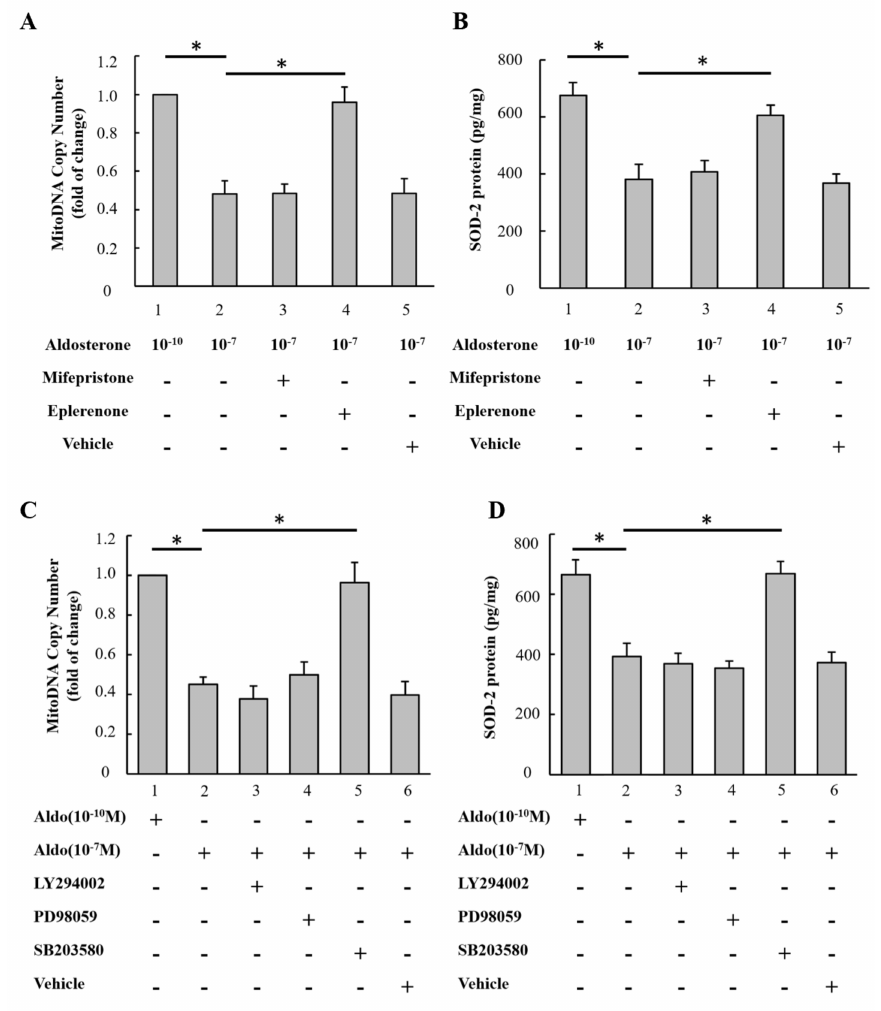
Figure 2. Aldosterone-associated reduction in mitochondrial DNA and protein via MR and MAPK/P38 pathway. ( A , B ) Role of MRs and glucocorticoid receptors on mitochondrial DNA and SOD2 protein. H9c2 cells were treated with 10 − 7 M eplerenone (an MR antagonist), 10 − 7 M mifepristone (a glucocorticoid receptor antagonist) and vehicle (equal volume of DMSO) for 1 h prior to 10 − 7 M aldosterone treatment. After 72 h, mitochondrial DNA was determined by qPCR and the expression of SOD2 was determined by ELISA. ( C , D ) Role of signaling mediators on mitochondrial DNA and SOD2. H9c2 cells were treated with 5 µ g/mL SB203580 (an MAPK/p38 inhibitor), 50 µ g/mL PD98059 (an MEK/ERK inhibitor), 50 µ g/mL LY294002 (a PI3K/ AKT inhibitor) or vehicle (equal volume of DMSO) for 1 h prior to 10 − 7 M aldosterone treatment. After 72 h, mitochondrial DNA was determined by qPCR and the expression of SOD2 was determined by ELISA. * p < 0.01, compared between the two groups indicated by the line